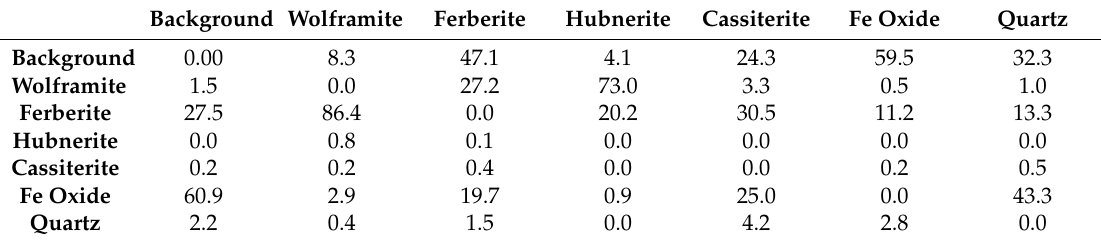
Figure 8. Ternary plot from EPMA analysis of points identified as ferberite by QEMSCAN. The circled region highlights points with relatively high manganese content which show little tungsten depletion. Table 4. Mineral associations within the LIMS waste stream sample as reported by QEMSCAN, each column totals to 100% association.